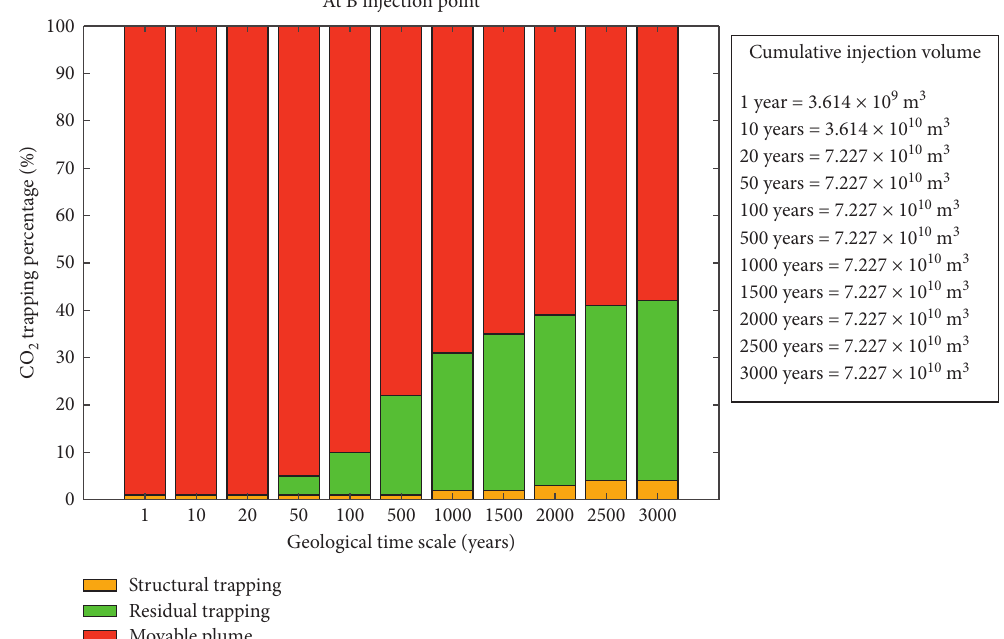
Figure 4: Histogram representing the percentage of CO 2 in the form of structural trapping, residual trapping, and movable plume. It is observed that the structural trapping and residual trapping contributions are increasing during the postinjection